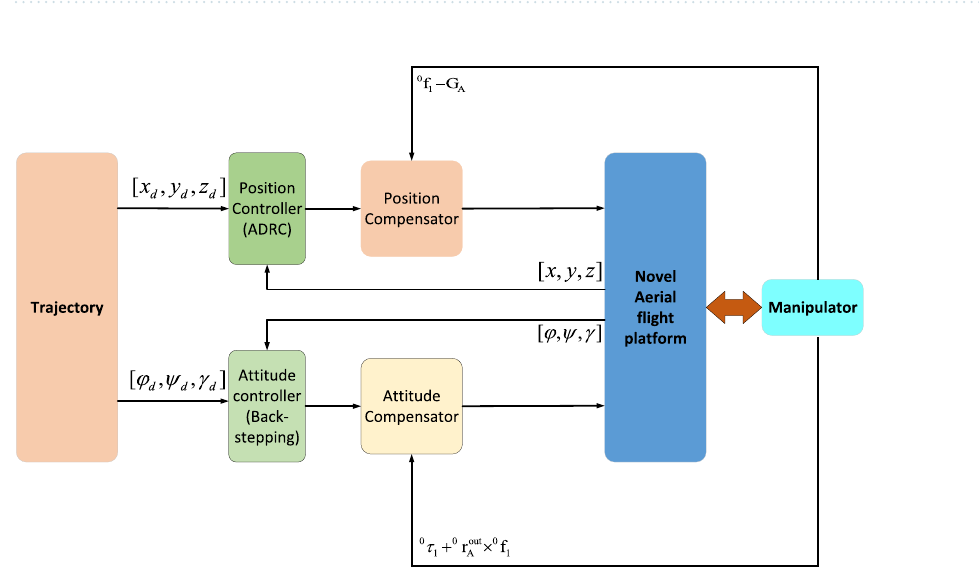
Figure 2. Control structure of the fully-actuated